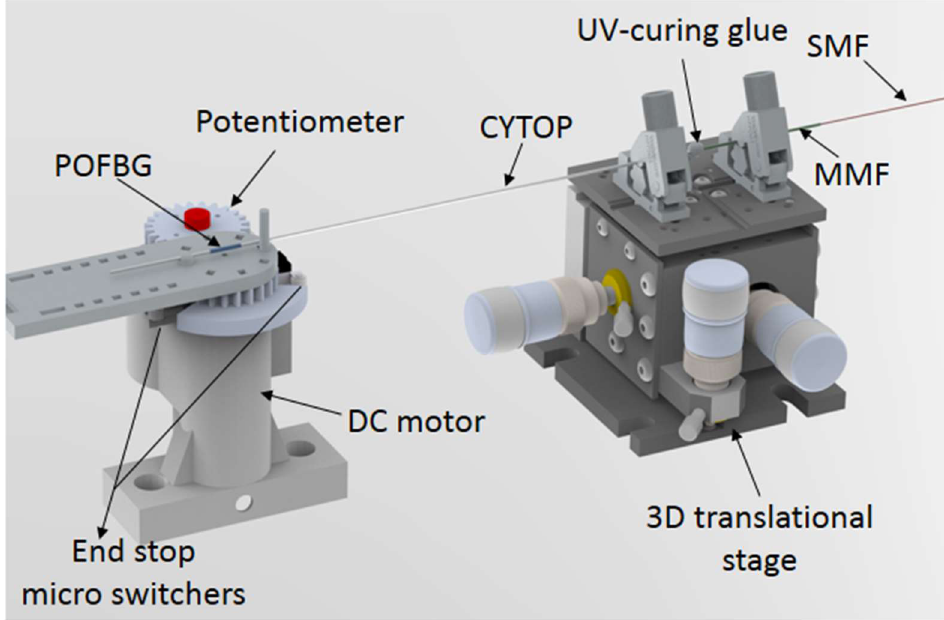
Figure 5. Experimental setup for the POFBG curvature sensor characterization.